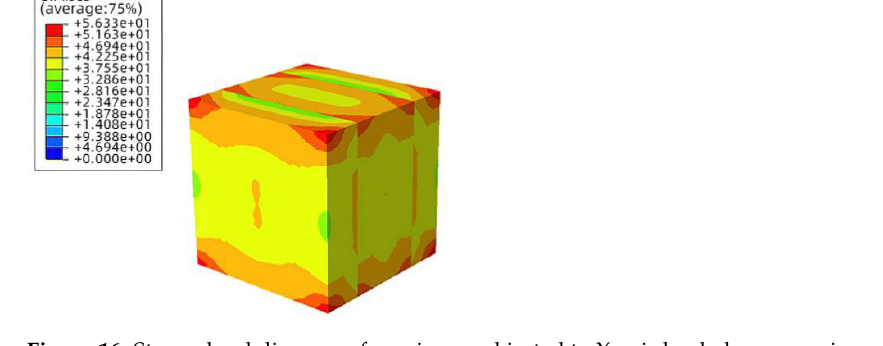
Figure 16. Stress cloud diagram of specimen subjected to X-axis loaded compression.